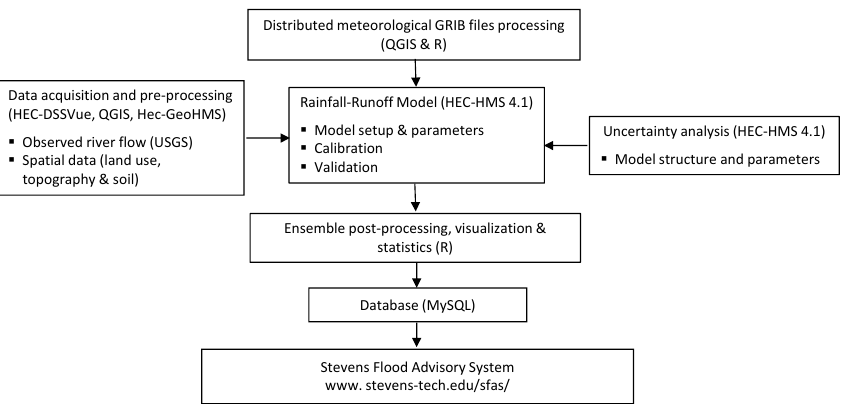
Figure 3. Framework design steps including spatial data and USGS discharge time series. Processing of general regularly distributed infor- mation in binary GRIB precipitation files data was carried out in Qgis (Qgis, 2011), R and Python, and exported to the HEC-DSSvue storage system. Basin parameters were derived for the study area and the hydrological model was run using these